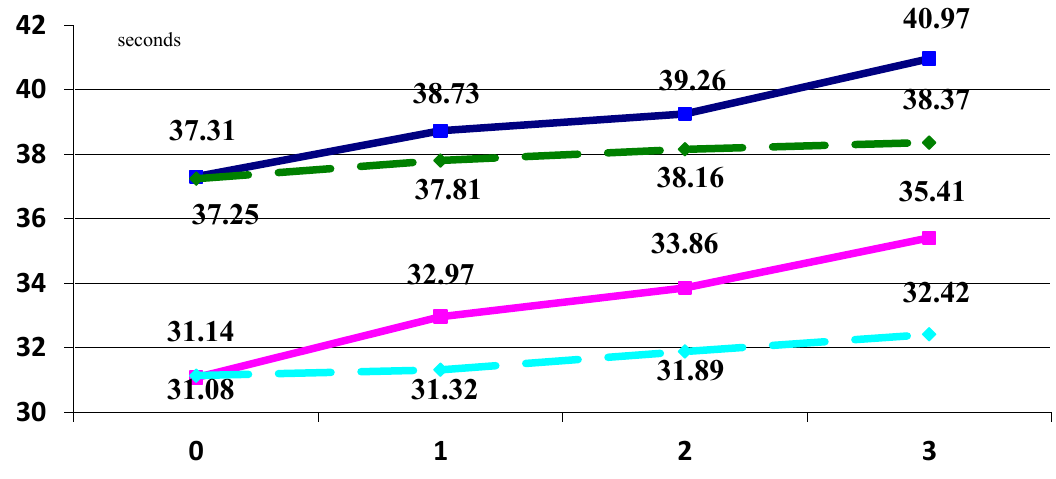
Fig.1. Dynamic of Shtange and Genchi’s tests results in experimental and control groups during formation experiment,